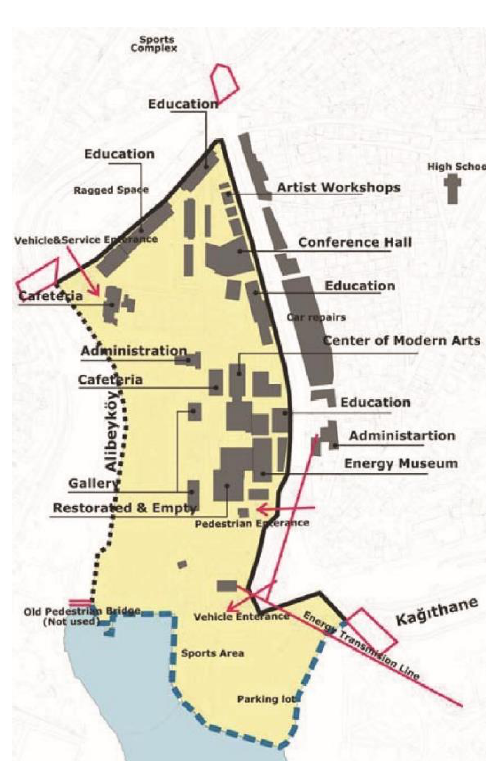
Figure 7. Silahtarağa Power Plant, site plan as it had evolved by 1984 (Brangar, 2004) Figure 8 reveals the main rooms of the factors which refers boiler rooms and groups of machine in the factory which organized in east-west horizontal axes. Considering the comb-shaped” arrangement